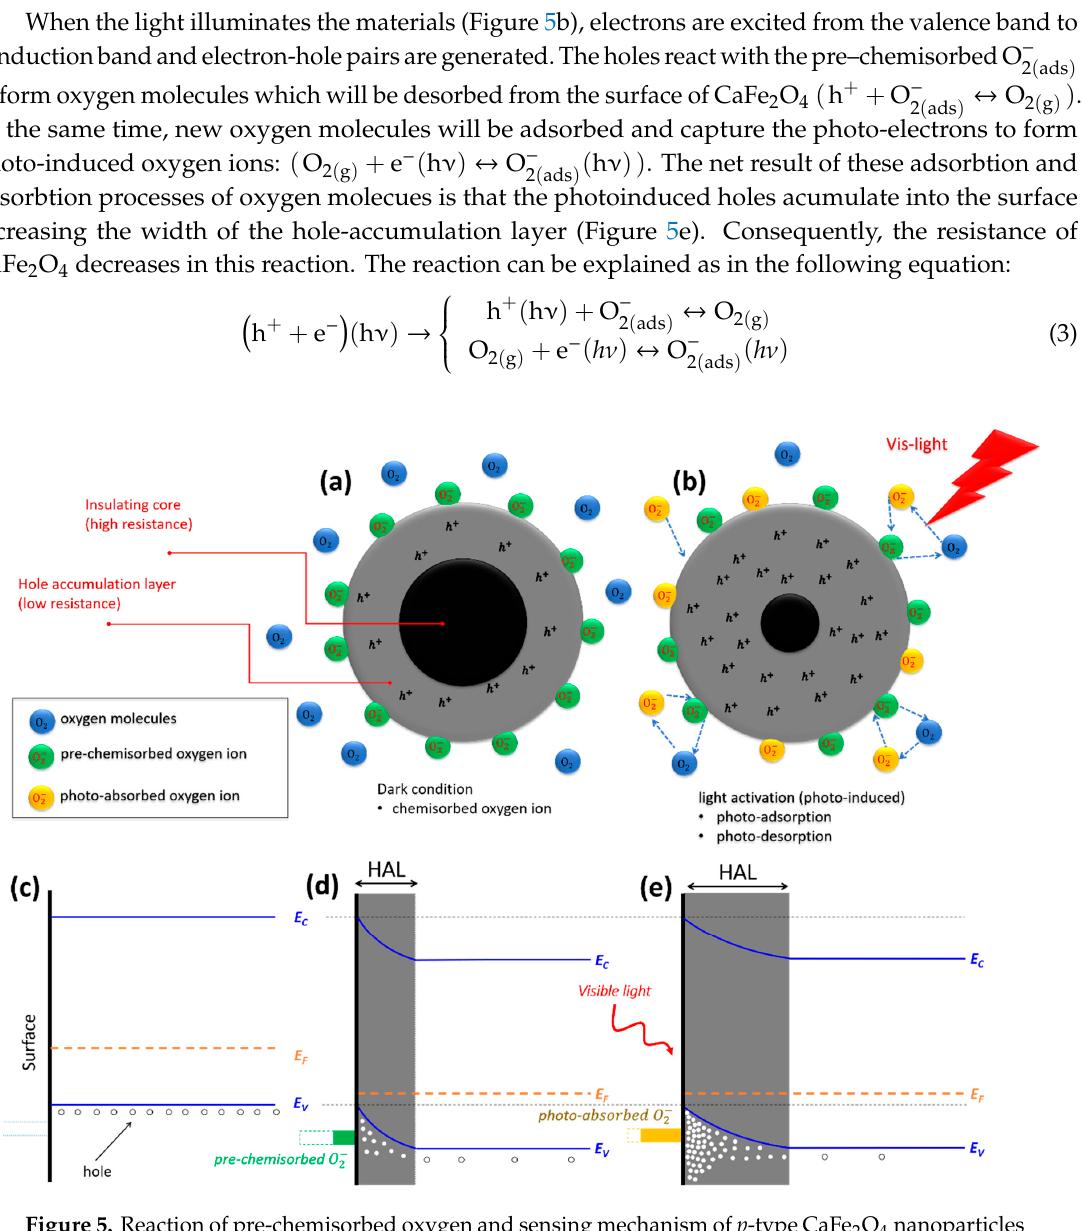
Figure 5. Reaction of pre-chemisorbed oxygen and sensing mechanism of p -type CaFe 2 O 4 nanoparticles based on density of charge in the core shell and energy band diagram ( a ) dark condition ( b ) photo-activation (i.e., light is ON) ( c ) condition prior to any surface reaction ( d ) trapping electron from the valence band due to the pre-chemisorption process in dark condition results in the formation of a hole-accumulation layer (HAL) ( e ) photo-activation process increases the density of majority charge (hole) resulting in a widening of HAL.